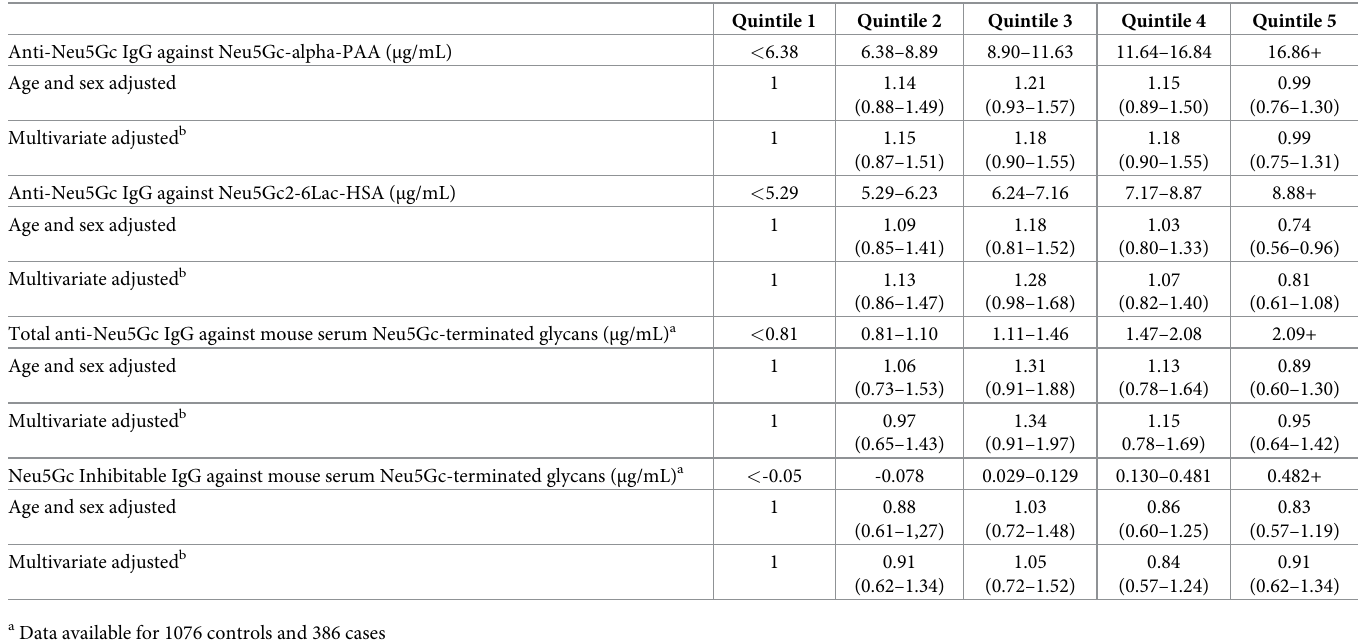
Table 3. Odds ratios for coronary heart disease by quintile of each analyte for 835 coronary artery disease cases and 1869 controls in the EPIC-Norfolk cohort.